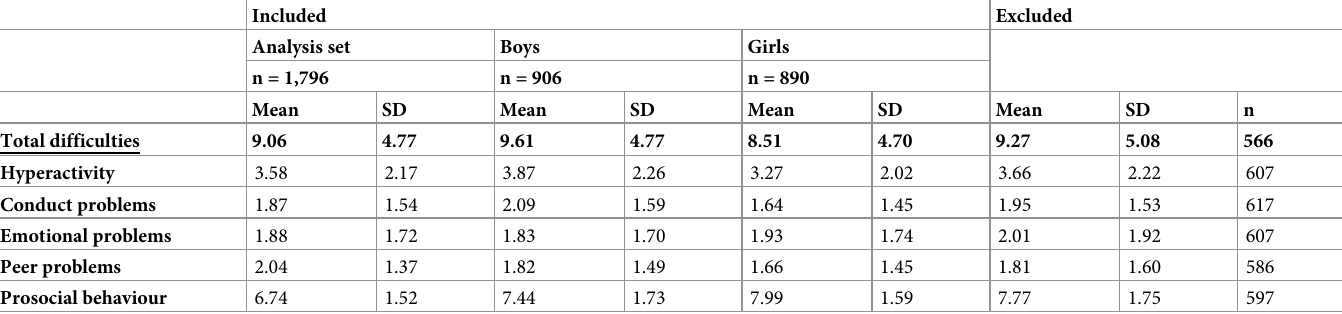
Table 3. Mean and standard deviation for scores on the strengths and difficulties questionnaire at age 7 in Czech ELSPAC cohort.